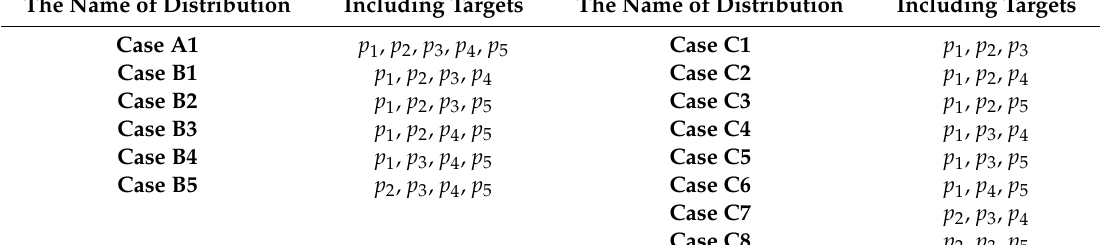
Figure 1. The target geometry of experiment I.